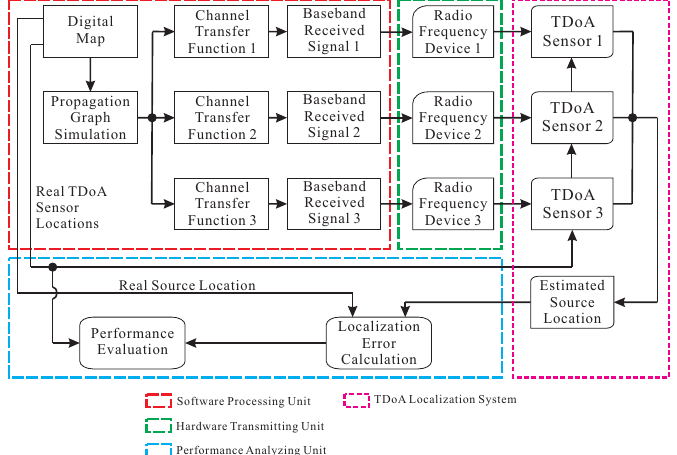
Figure 1. The block diagram of the proposed performance-evaluation approach for a time difference of arrival (TDoA) localization system.